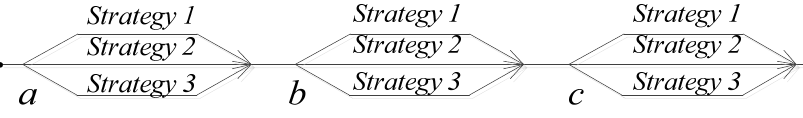
Figure 10. Decision tree. Figure 10. Decision